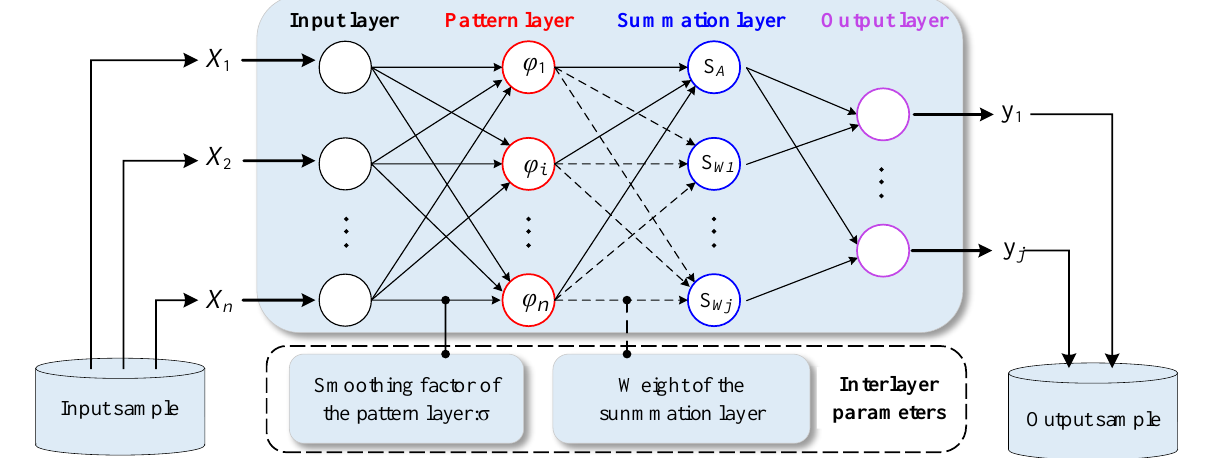
Figure 7. GRNN model building process.